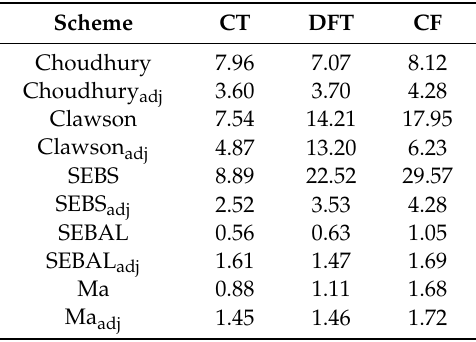
Table 5. VR accuracy , the ultimate sensitivity coe ffi cient, of these schemes.